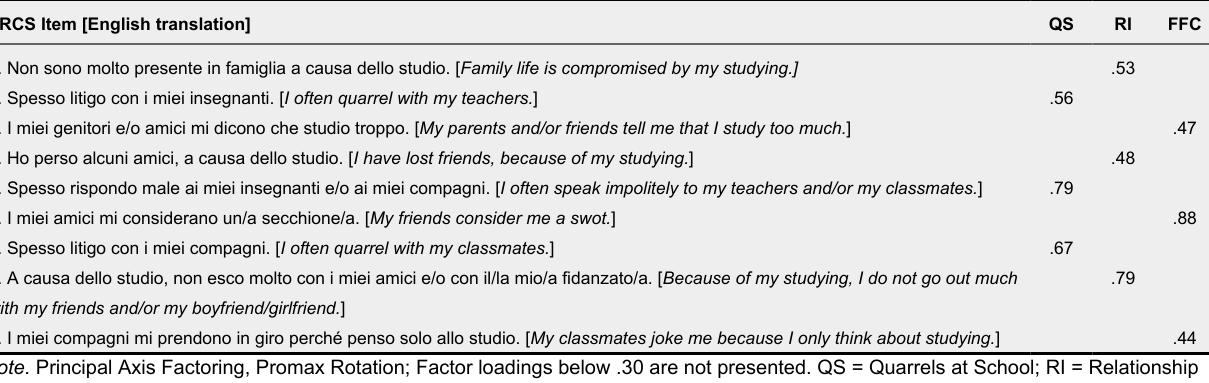
Exploratory Factor Analysis of the Study-Relationships Conflict Scale (SRCS), n = 290